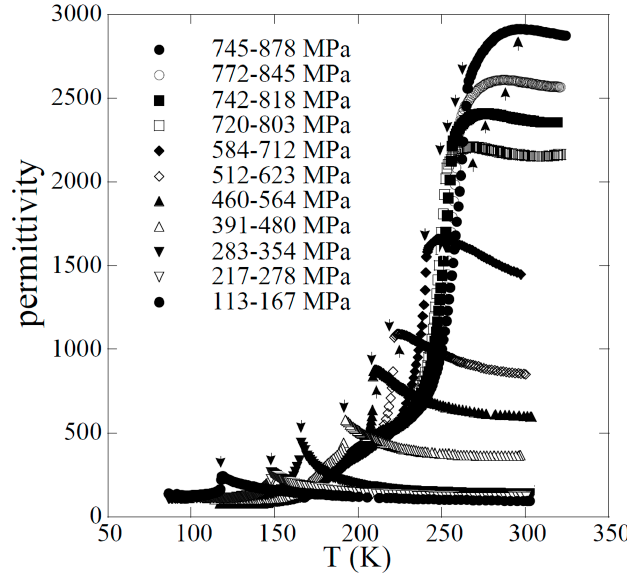
Figure 13. Temperature dependence of the dielectric permittivity measured at 13 MHz in the direction parallel to the stacking axis for different pressures. The down arrows mark the ferroelectric transition (jump) and the up arrows mark the maximum.